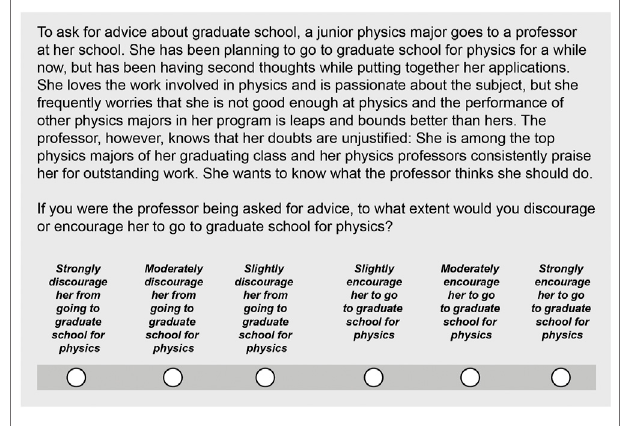
FIGURE 1 | Example of a vignette and question pair as presented to respondents in our survey. This is the “ match ” vignette for a hypothetical female undergraduate. Each professor was presented vignettes of an additionaltwohypotheticalundergraduates( “ Con fl ictingpersonalgoals ” and “ Loss of interest ” vignettes). The gender of the undergraduate was randomly assigned, and all three vignettes shared the same gender.